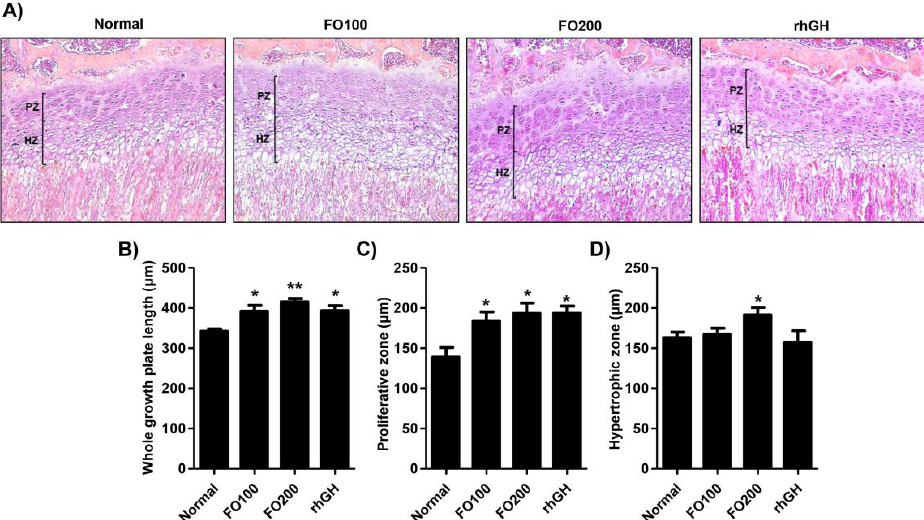
Figure 3. Histology of the proximal tibial growth plate in the Sprague-Dawley rats and height measurements. ( A ) Hematoxylin & eosin (H&E) staining of the proximal tibial growth plate (100 × magnification). ( B ) Heights of the entire growth plate were measured on tibial sections stained with H&E. ( C ) Length of the proliferating zone in the growth plates. ( D ) Length of the hypertrophic zone in the growth plates. Heights were measured on tibial sections stained with H&E (100 × ). Data are expressed as means ± SD ( n = 6). * p < 0.05 and ** p < 0.01 vs. normal. PZ, proliferating zone; HZ, hypertrophic zone. Molecules 2020 , 25 , x FOR PEER REVIEW